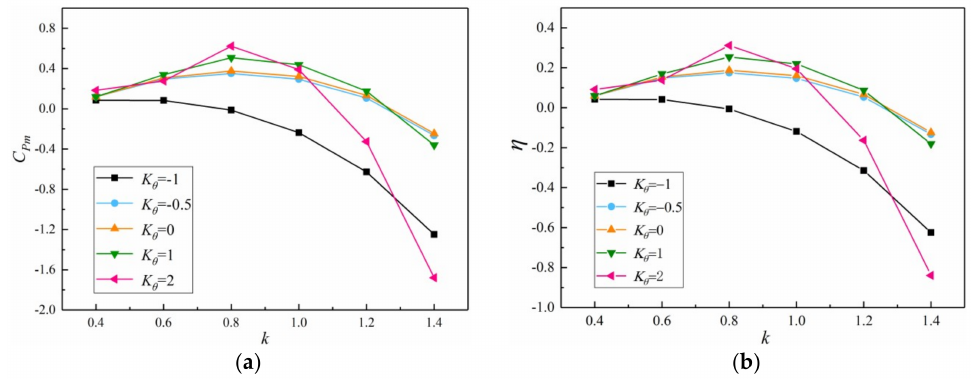
Figure 9. The C Pm and η of parallel foils at different K θ : ( a ) C Pm curves under different k ; ( b ) η curves under different k .